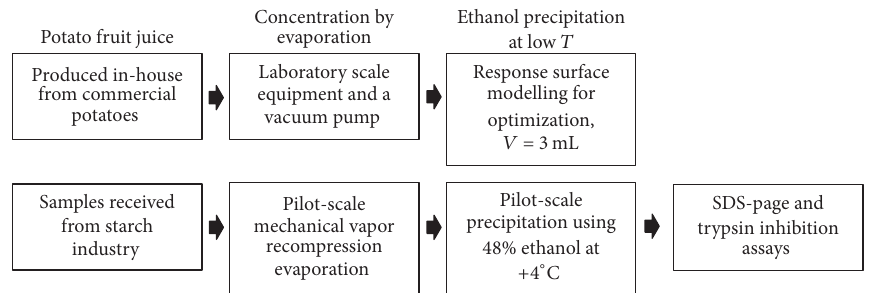
Figure 1: Experimental procedures in the present research. The upper row represents the procedure to optimize the precipitation conditions using commercial potatoes. The lower row represents the procedure to utilize optimized conditions at starch industry for the pilot-scale precipitation.